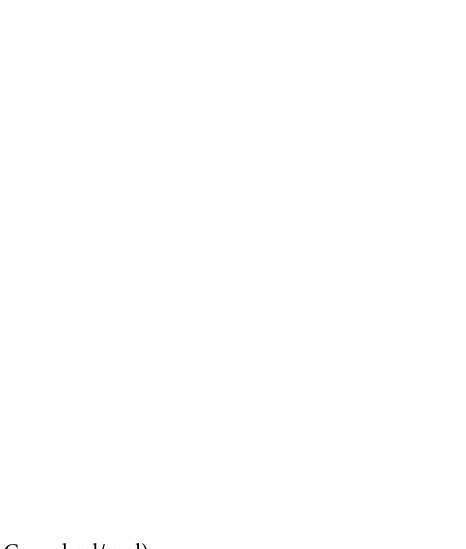
Table 2. Calculated PNP-to-PPN isomerization energy (ΔG PPN ,